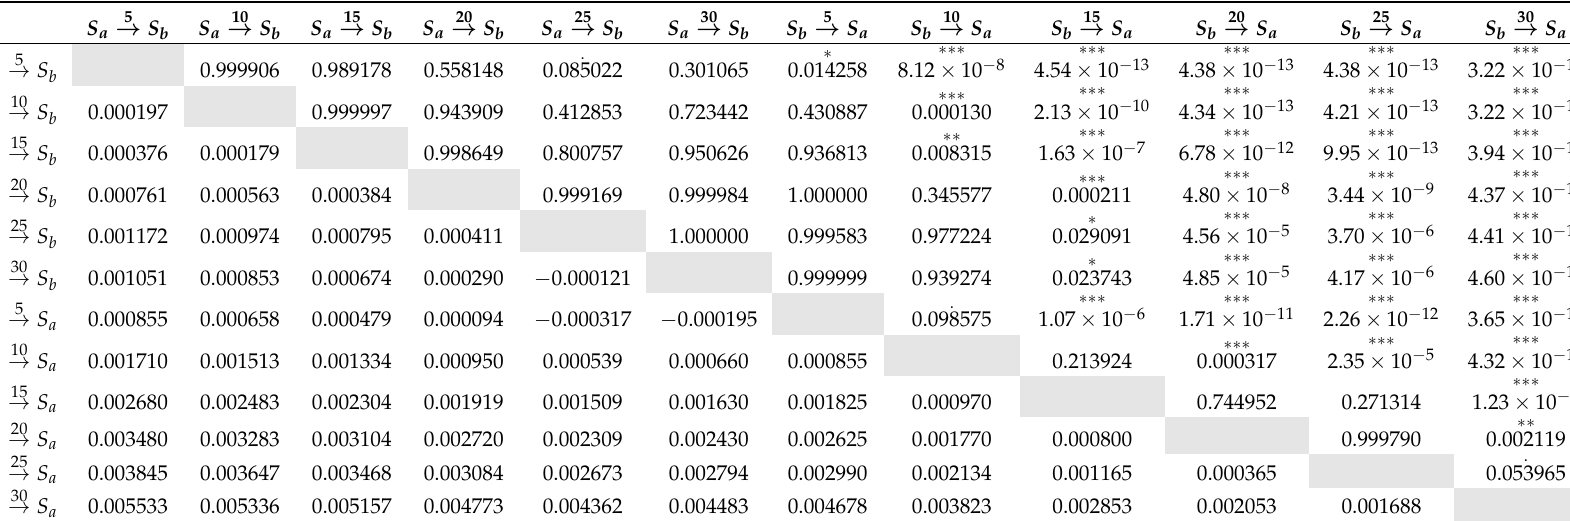
Table 3. Differences of means of the mean squared error (MSE) (Wilcoxon rank-sum test) between groups in the lower triangle and p -value in the upper triangle with significance symbol (., *, **, *** indicate statistical significance at the 90%, 95%, 99% and 99.9% levels,